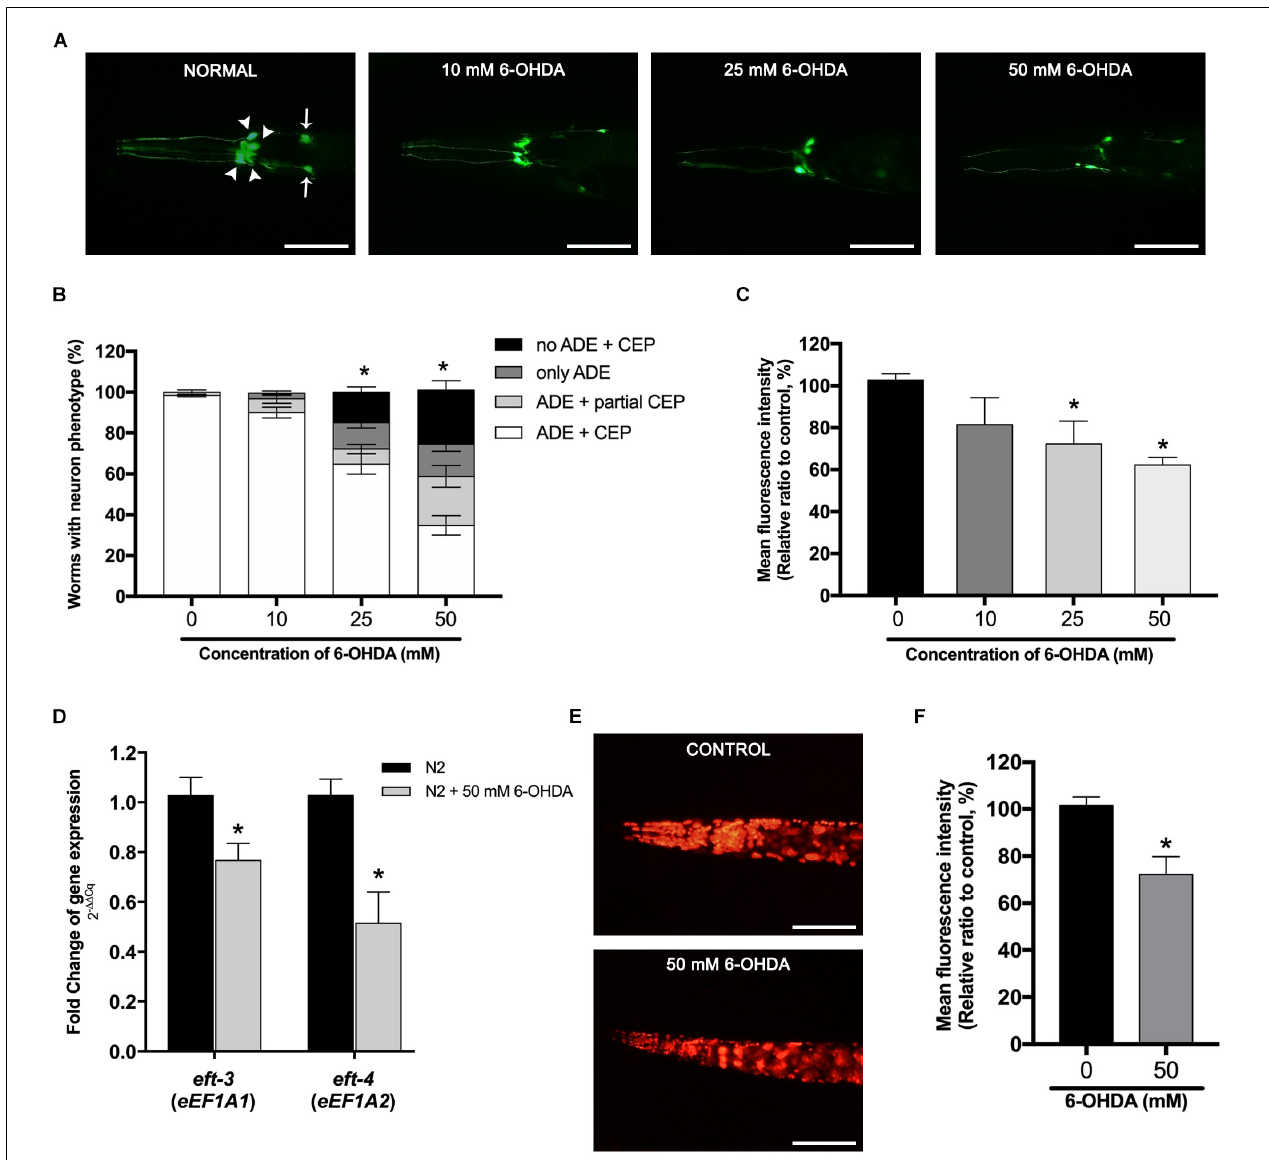
FIGURE 1 | Effects of 6-hydroxydopamine (6-OHDA) exposure on dopaminergic (DA) neurons and the mRNA expression of the eft-3 and eft-4 in Caenorhabditis elegans. (A) Green fluorescent protein (GFP) expression pattern in DA neurons of control transgenic BZ555 strain, and 10, 25, and 50 mM 6-OHDA-treated worms. In normal BZ555 worms, white arrowheads point to cell bodies of four cephalic neurons (CEP), while white arrows indicate the location of two anterior deirid neuron (ADE) cell bodies. Scale bar, 50 µ m. (B) Graphical representation for percentage of DA neurons phenotype worms. Animals possessing all neurons were scored as “ADE + CEP” (white bar), those with partial loss of CEP but intact ADE neurons as “ADE + partial CEP” (light gray bar), those with complete loss of CEP but intact ADE neurons as “only ADE” (dark gray bar), and those with complete loss of DA head neurons as “no ADE + CEP” (black bar). The asterisk (*) indicates the significant difference of percent worm with normal ADE + CEP phenotype between untreated and 6-OHDA-treated worms ( p < 0.05). (C) Graphical representation for mean fluorescence intensity (MFI) of GFP expression in DA neurons of BZ555 strain as measured by using ImageJ software. (D) Fold change of mRNA expression levels of eft-3 and eft-4 between normal N2 worms and 50 mM 6-OHDA-treated worms. (E,F) GFP expression and graphical representation for MFI of red fluorescent protein (RFP)-tagged eft-3 in SD1340 strain and 50 mM 6-OHDA-treated worms. The data represent the mean ± SEM of three independent biological replicates, each with 40–50 animals. For (C–F) , the asterisk (*) indicates a significant difference between the untreated and 6-OHDA-treated worms ( p <